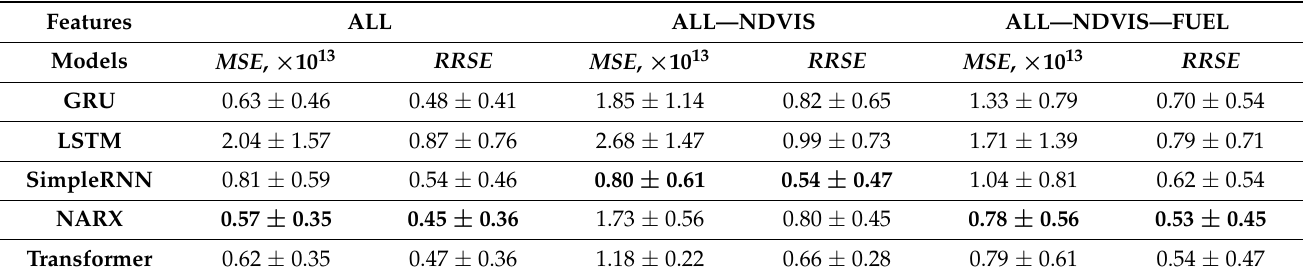
Table 3. Export prediction scores for the baseline